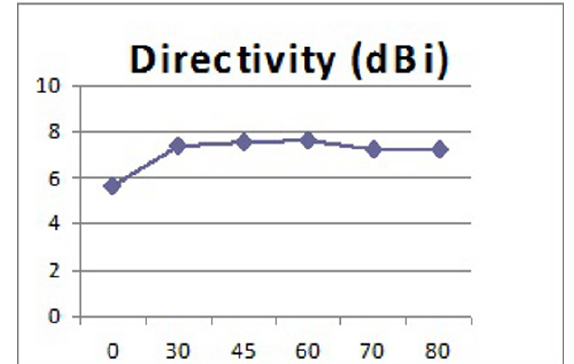
Figure 16. Chart showing variation in Directivity (dBi) vs. Flare angle (degrees).